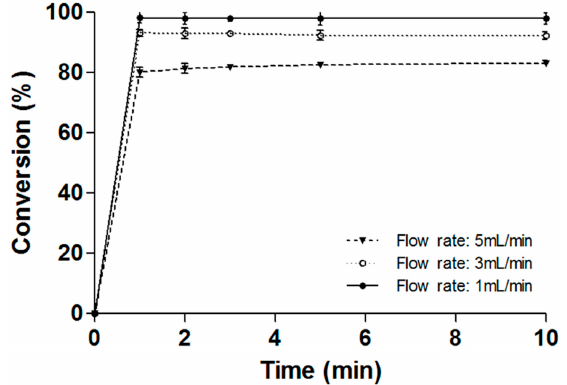
Figure 2. Effect of flow rate on the lipase-catalyzed synthesis of 2-PEAc in a packed-bed reactor at a substrate concentration of 100 mM 2-phenethyl alcohol (2-PE) and temperature of 55 °C.